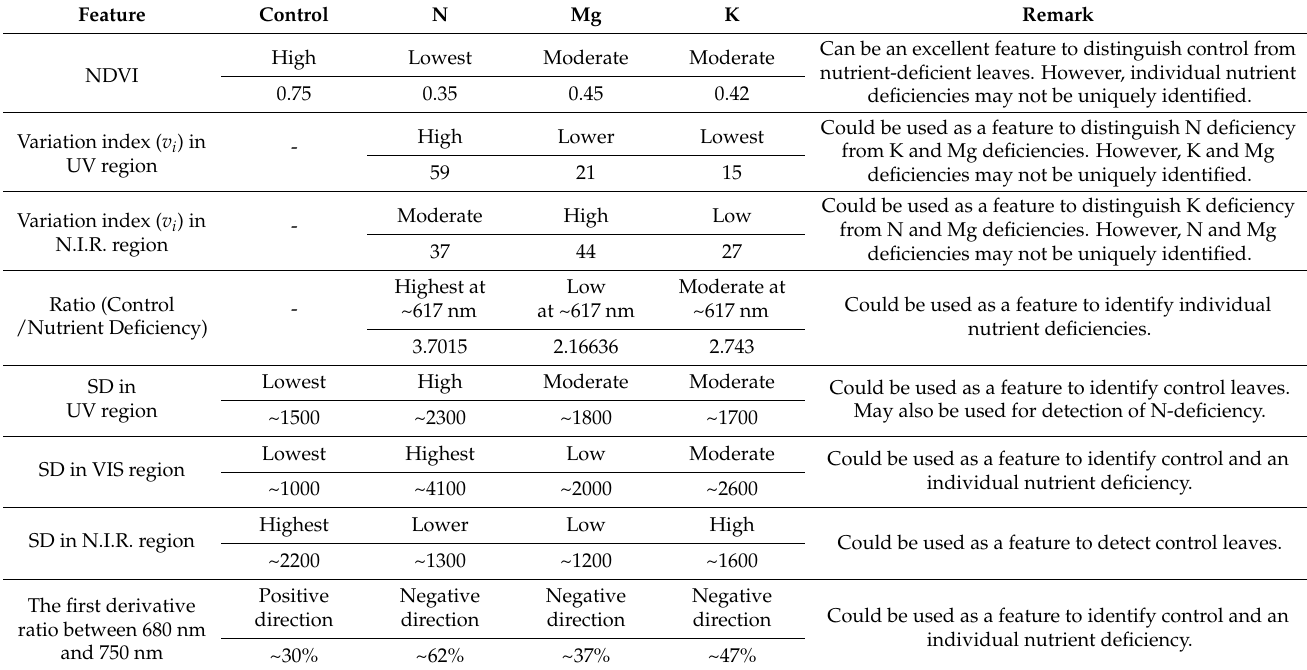
Table 2. Summary of features for comparison study between control and individual nutrient-deficient leaves.